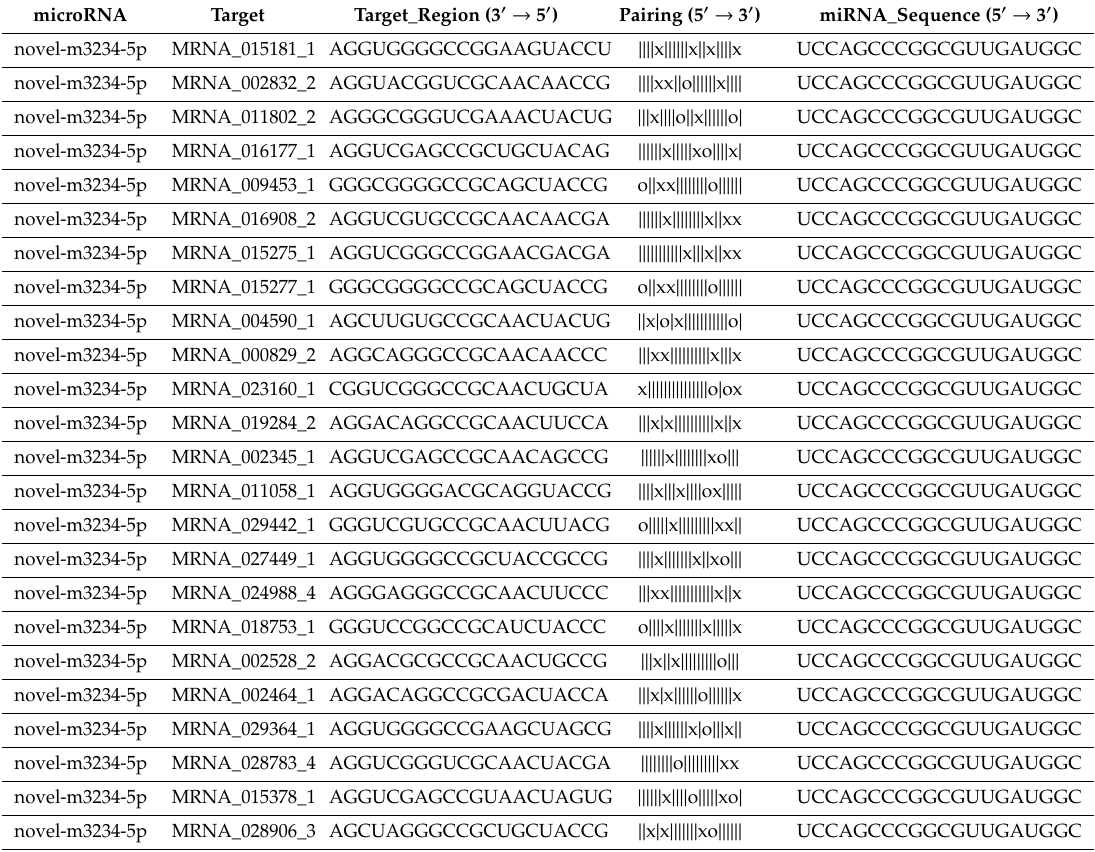
Table 2. Complementary between novel-m3234-5p and